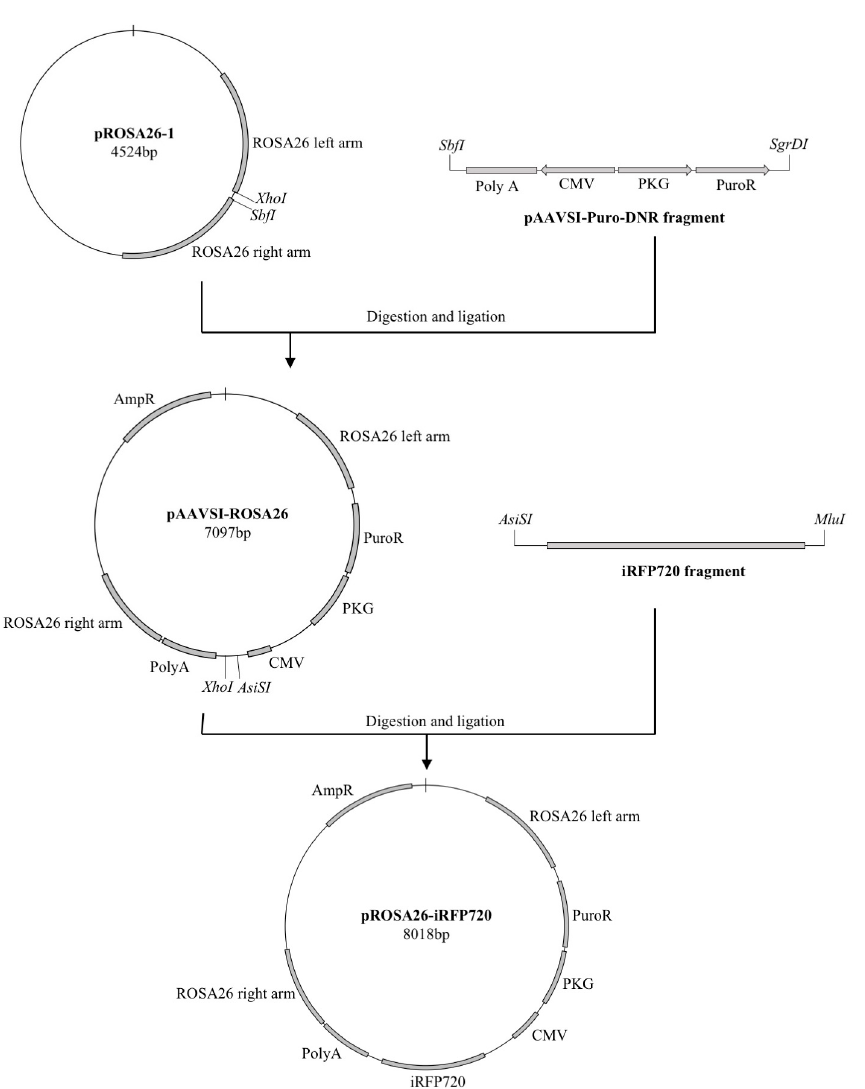
Figure 1. Strategy for pROSA-puro-iRFP720 vector generation and genomic screening. Schematic representation of the overall cloning strategy for the generation of the pROSA-puro-iRFP720 vector. A fragment from the pAAVS1-puro-DNR plasmid was PCR-amplified, digested with SbfI and SgrDI and ligated into an SbfI/XhoI-digested pROS A26-1 plasmid. An iRFP720 fragment from piRFP720-N1 was PCR-amplified, digested with AsiSI and MluI and ligated into the AsiSI/MluI-digested pAAVSI-ROSA26